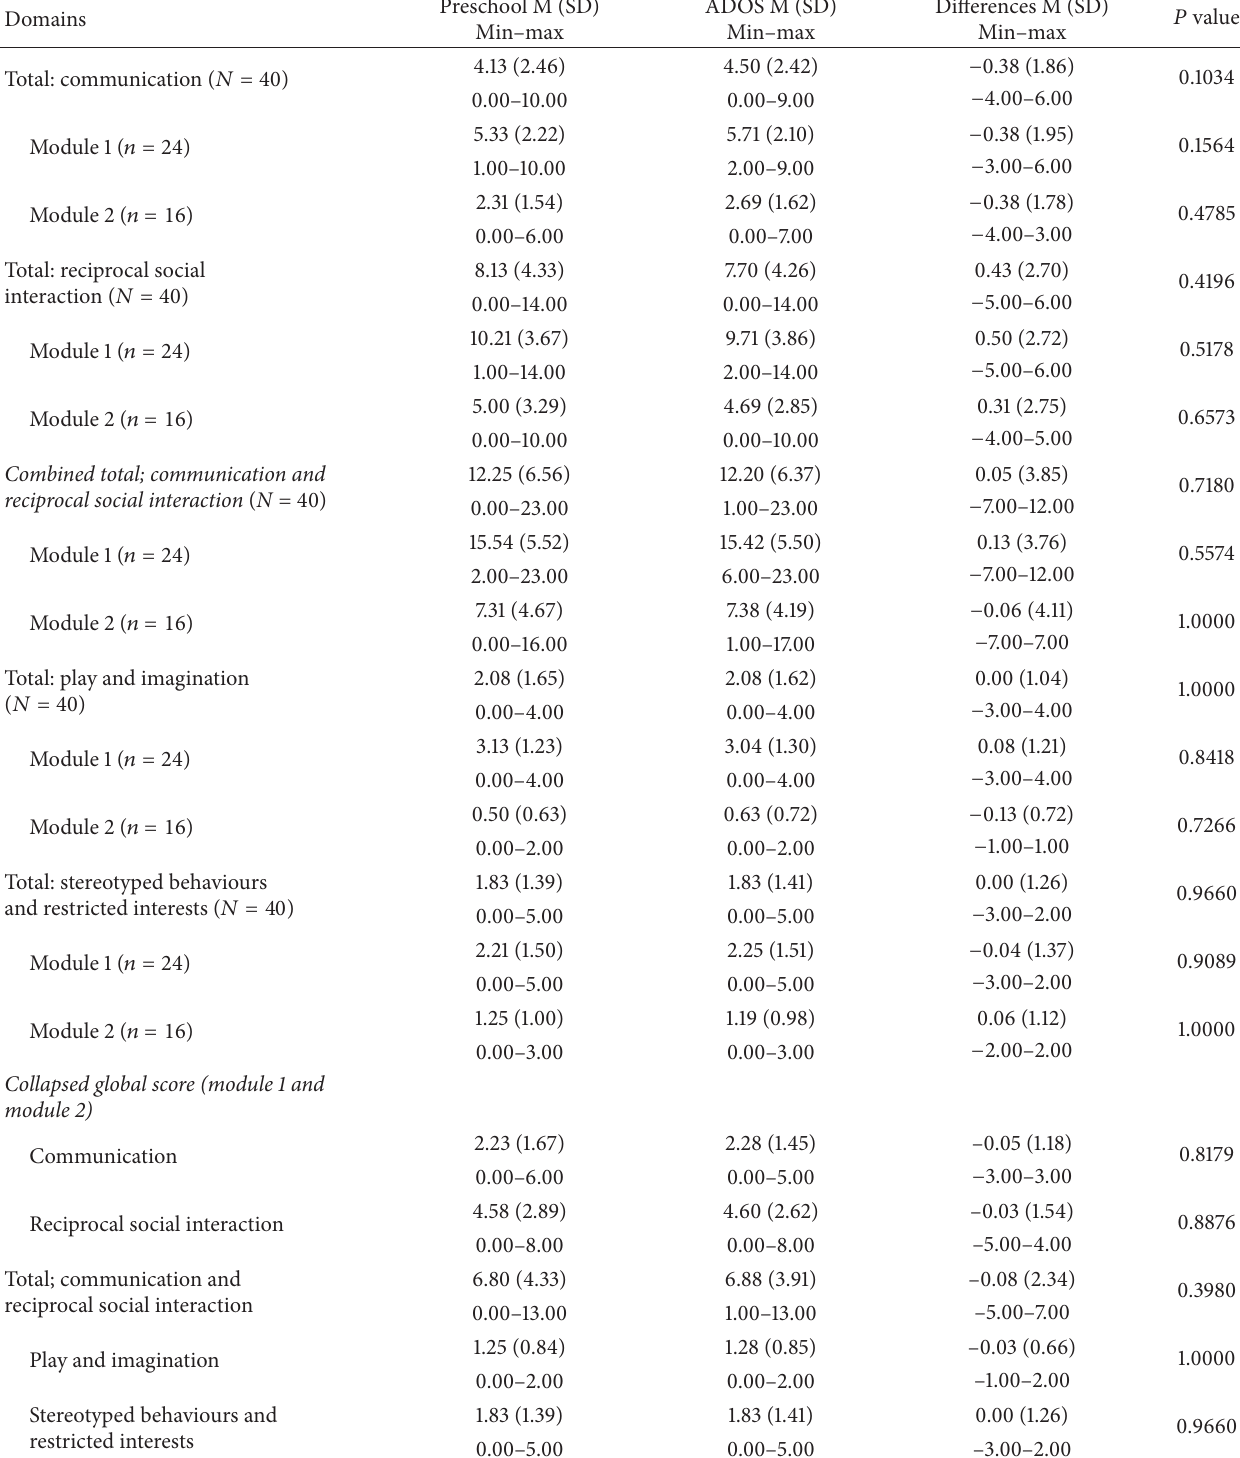
Table 4: Comparison between the total score in the different domains of preschool observation and